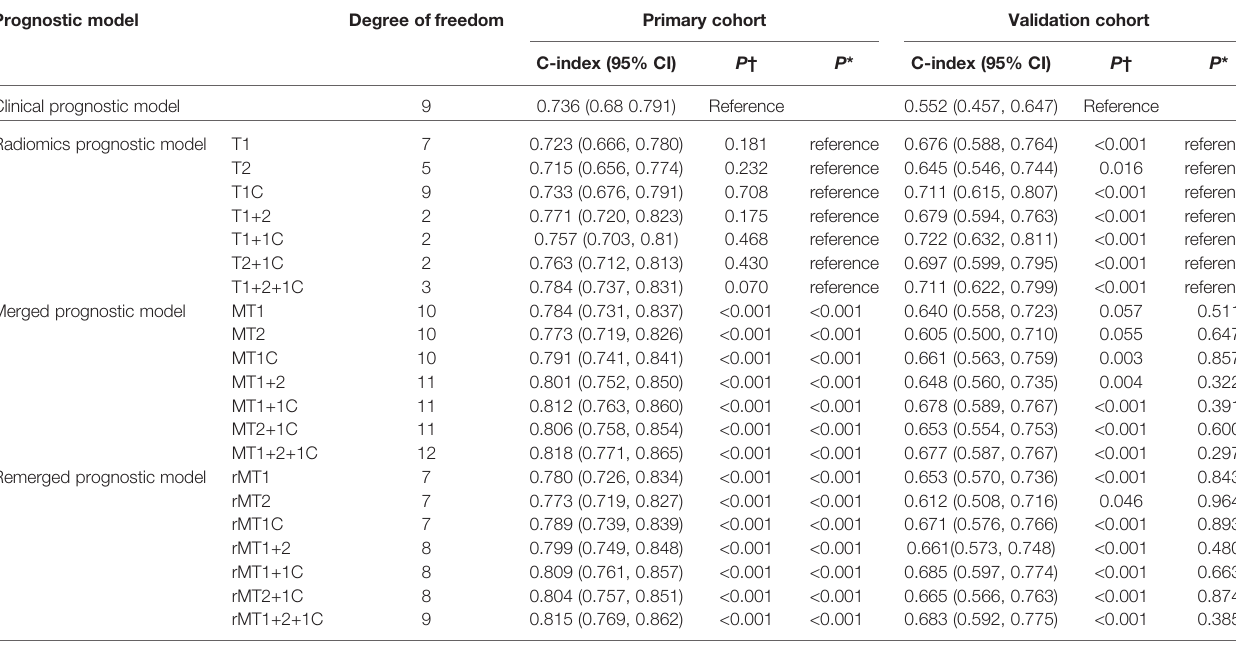
TABLE 2 | C-index values of different prognostic models for DMFS prediction in the primary and validation cohorts. Prognostic